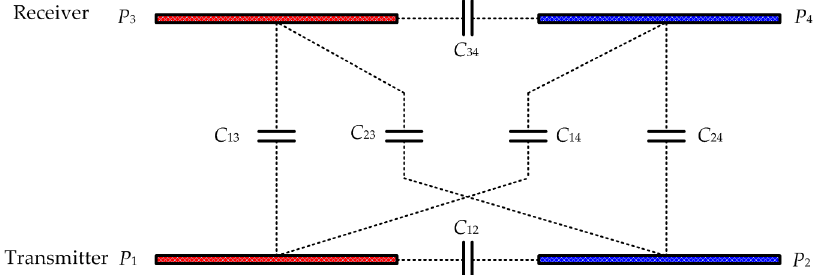
Figure 22. Structure of a four-plate parallel capacitive coupler.